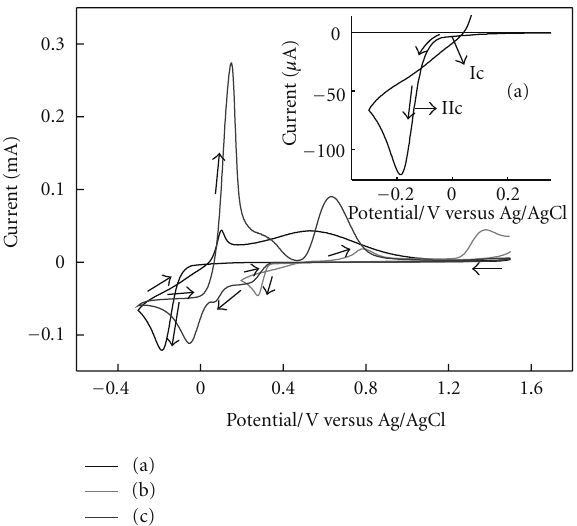
Figure 2: Cyclic voltammograms of the BDD electrode in solutions containing (a) 5 mM Cu(II), (b) 1mM Pd(II), and (c) 5mM Cu(II) + 1 mM Pd(II). All solutions containing 0.5 M HClO 4 as supporting electrolyte. Scan rate of 10 mVs − 1